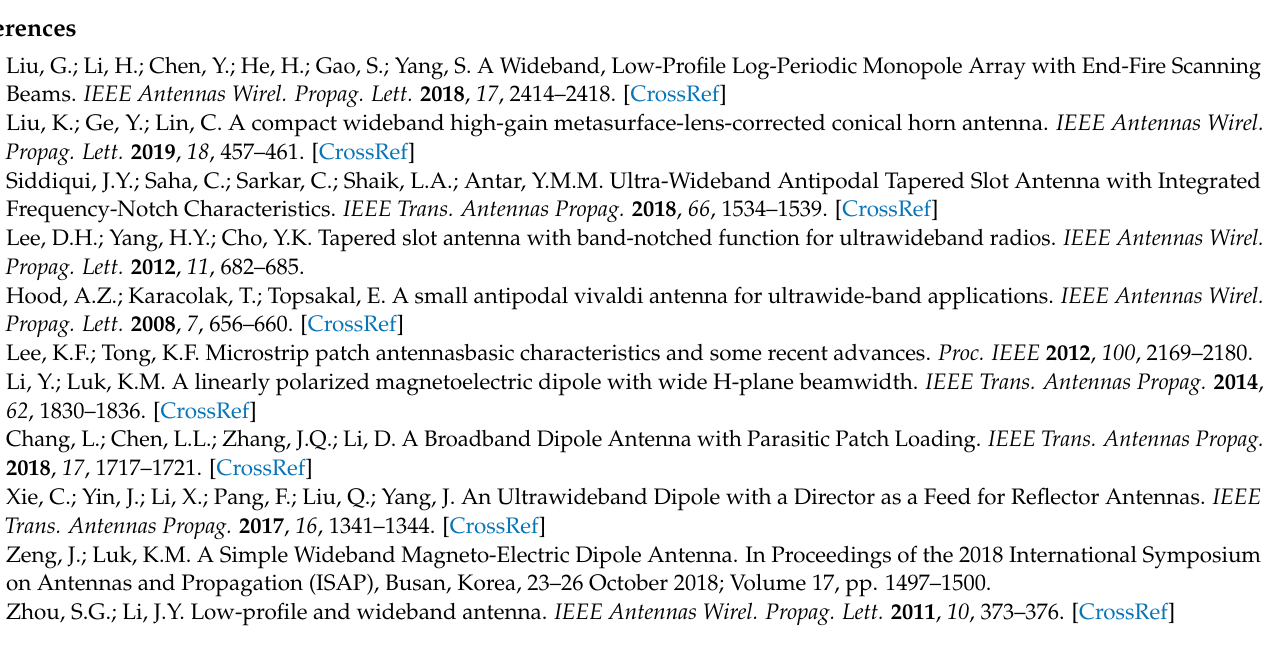
Figure 17. Simulated and measured realized gains of the proposed antenna.